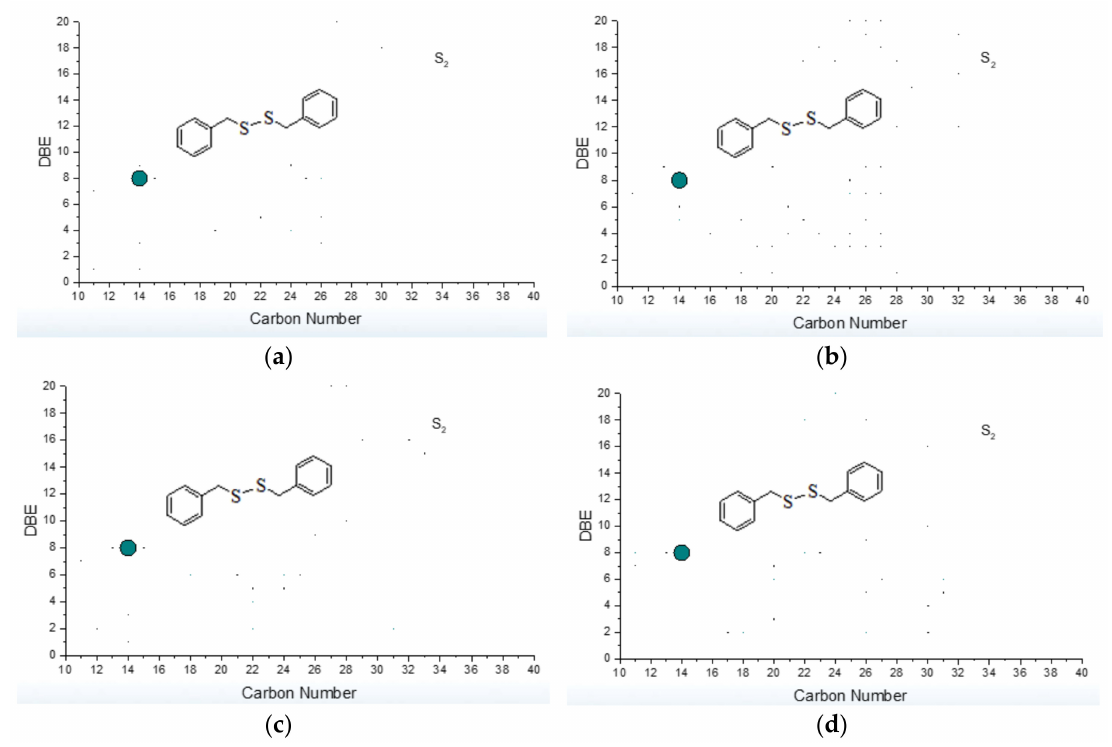
Figure 6. The FT-ICR MS distribution of disulfide compounds: ( a ) WLT, ( b ) HCT, ( c ) QZT, and ( d ) HLT.